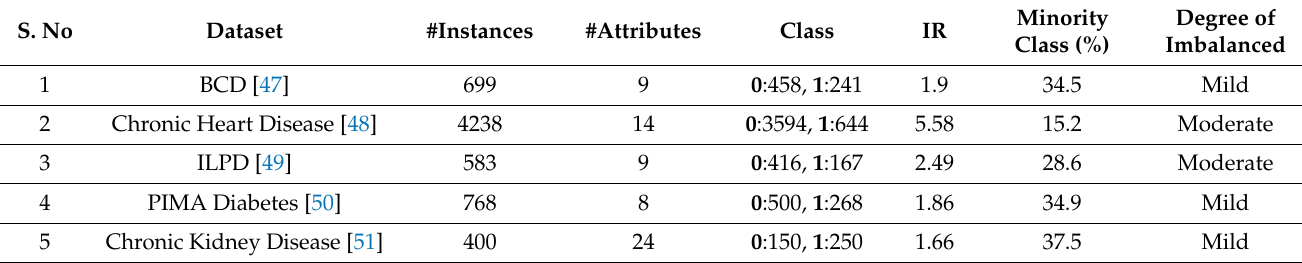
Table 4. Dataset description before applying data-balancing